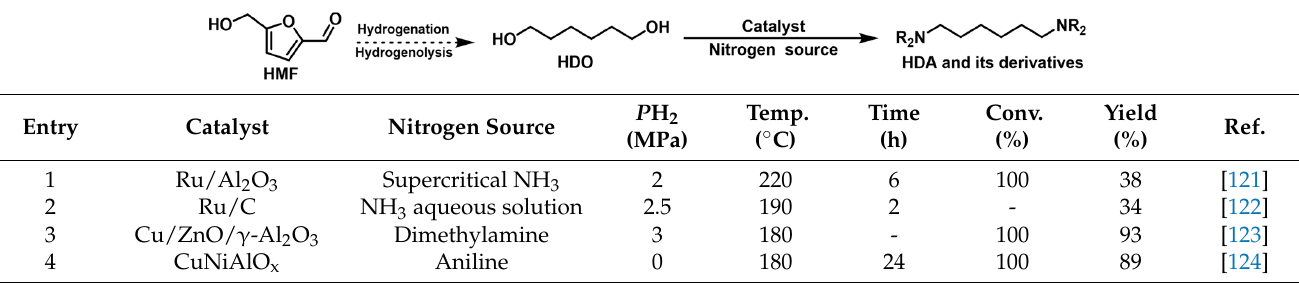
Table 8. Hydrogen-borrowing amination of HDO with different nitrogen sources.